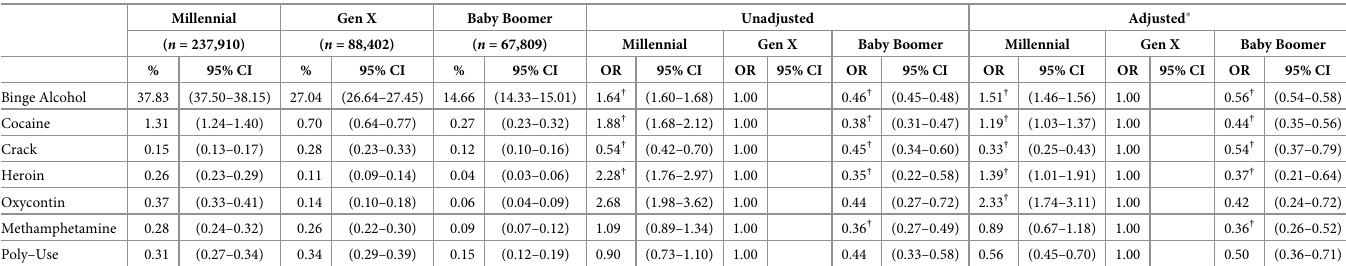
Table 2. Unadjusted and adjusted multiple logistic regression of generational cohort associated with past-month substance use and poly-use for adults, 2007–16.